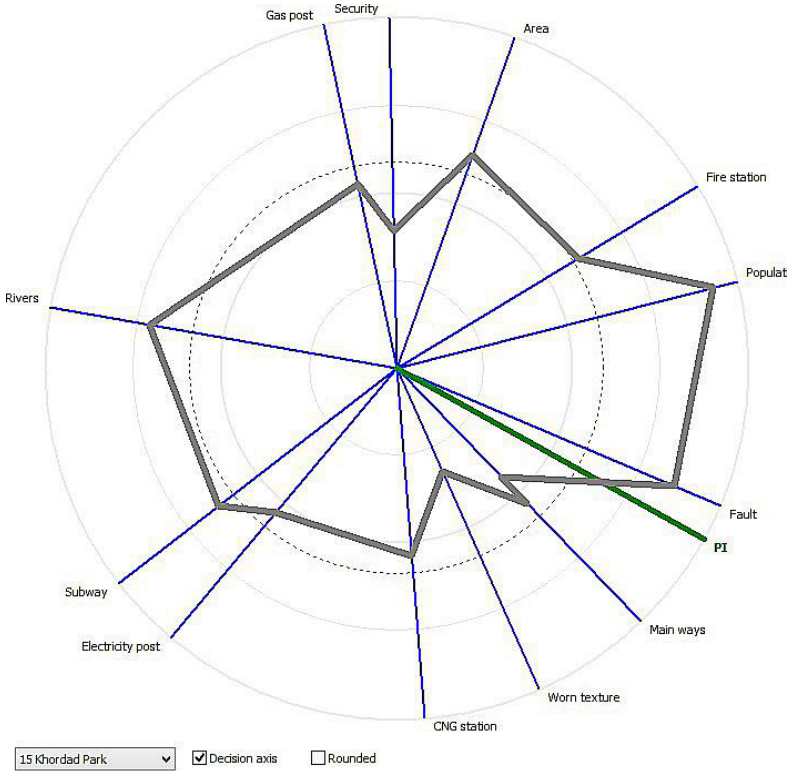
Fig. 6. GAIA web option 15Khordad